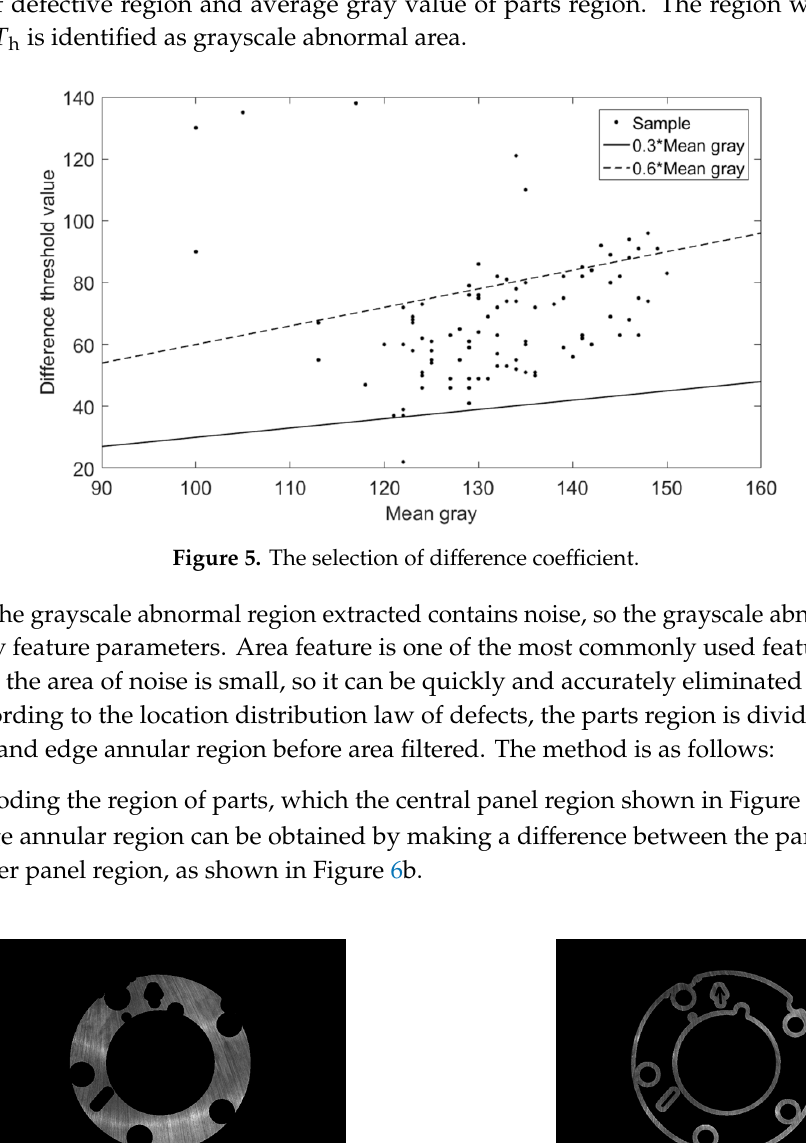
Figure 5. The selection of difference coefficient.